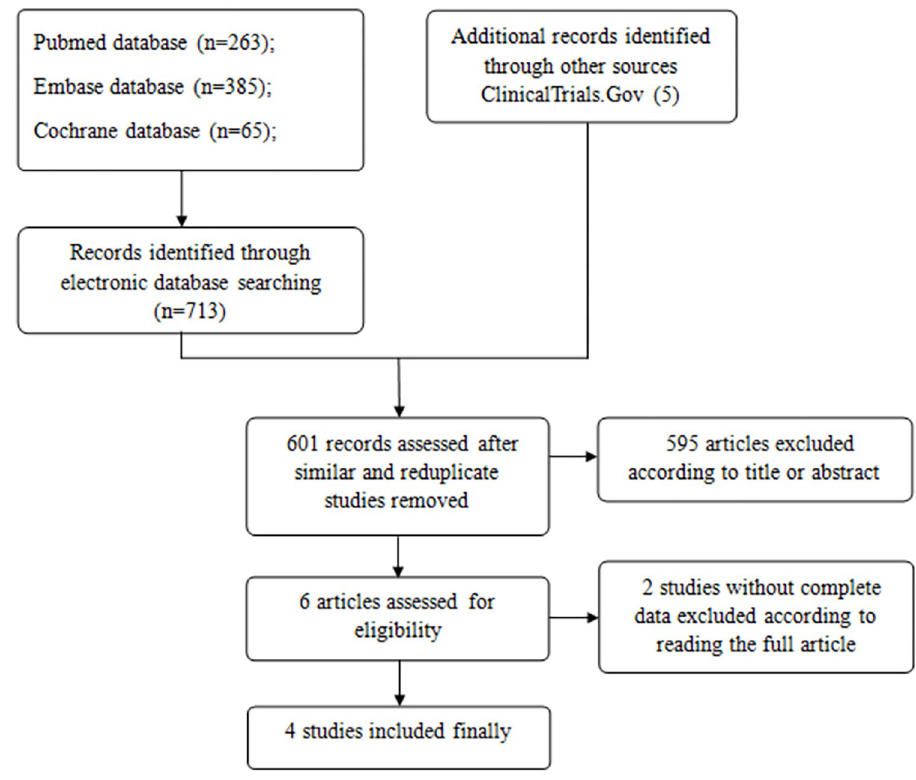
Fig 1. PRISMA flow diagram of study